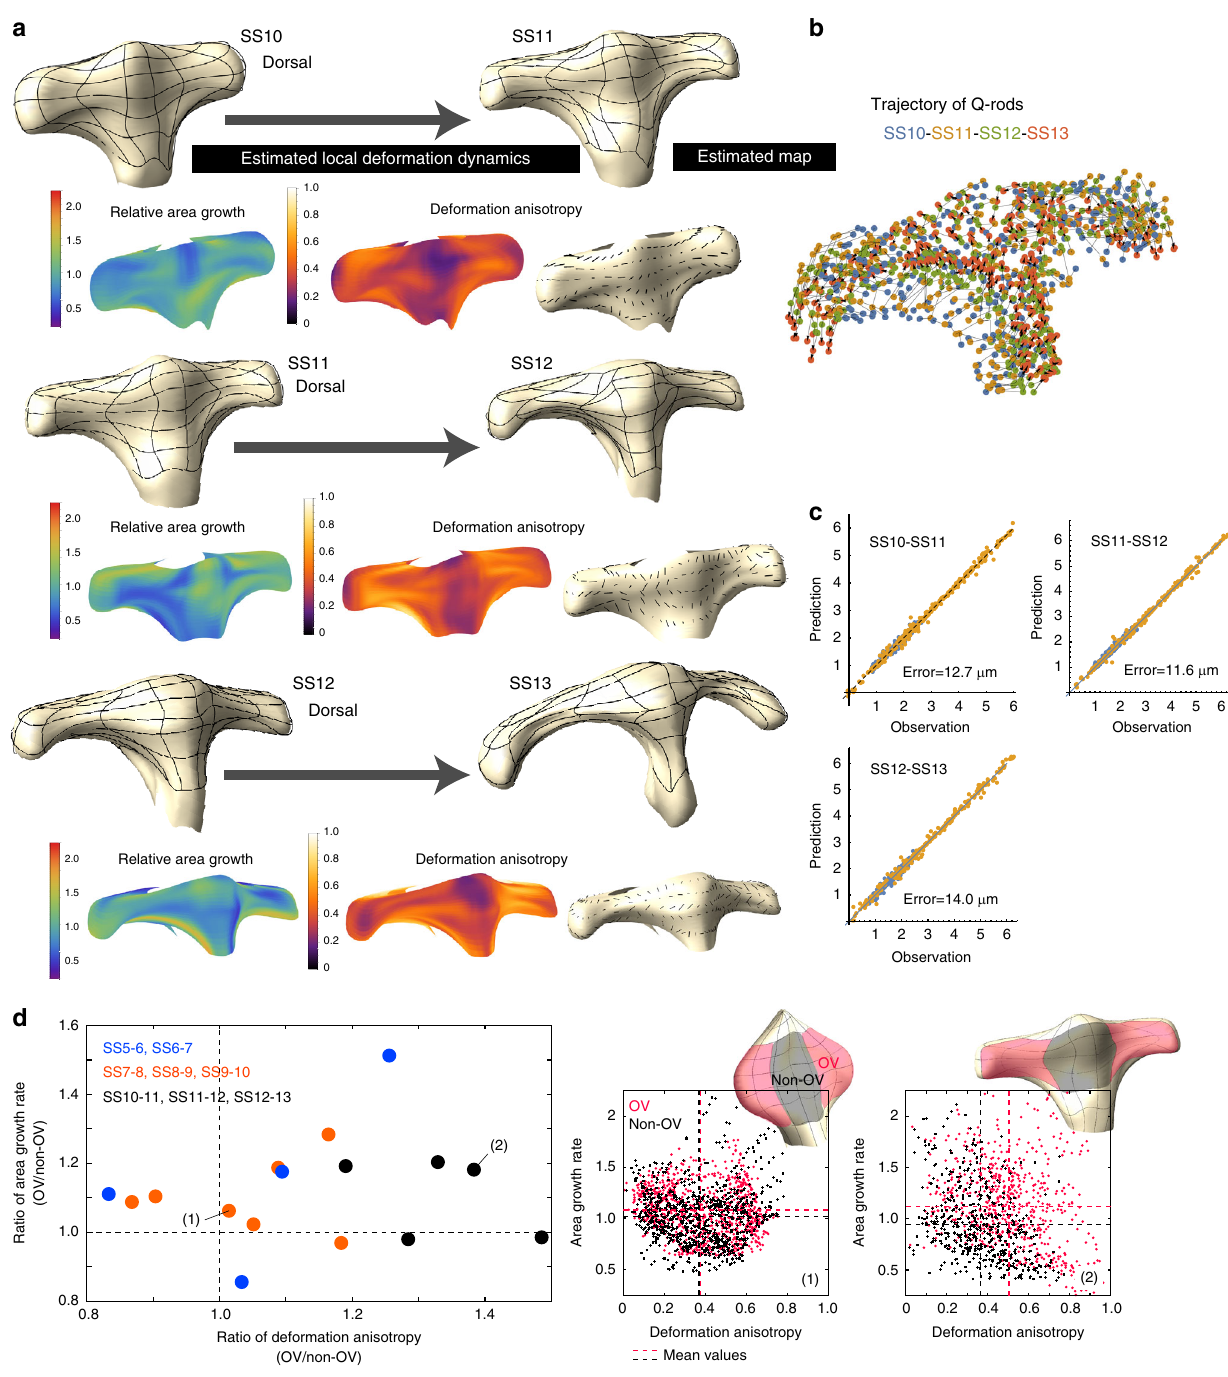
Fig. 7 Application to chick forebrain morphogenesis from SS10 to SS13. a Estimated deformation maps and spatial patterns of local deformation characteristics from SS10 to SS13 for one embryo. Due to limitations in the imaging resolution, deformation dynamics were only analyzed for the dorsal apical surface (see Supplementary Fig. 11(D) for results from another embryo). As with the case for SS5-SS10, no clear bias in area growth rate was observed. In regards to deformation anisotropy, its value remained high especially in the OV region (or evaginated region). During these somite stages, differences in the degree of anisotropy were clearer between OV and non-OV regions (quanti fi ed in ( d )). The direction of deformation anisotropy was generally biased along the medio-lateral axis although the pattern was growing more complex with the increasing morphological complexity. b Trajectory data from small aggregates of Q-rods (ranging 1 – 20 micrometers in diameter) attached to the apical surface that were used to infer the tissue deformation map. c The precision of the estimated maps was evaluated by prediction errors. The mean prediction error was on the order of a few cell diameters (on the apical surface). The yellow and blue dots indicate results for the u 1 and u 2 coordinates, respectively. d Quantitative comparison of tissue deformation characteristics on the dorsal surface between OV and non-OV regions. The left graph shows the ratio of the average degree of deformation anisotropy and the ratio of average area growth rate between these two regions. Each point shows a result for each reconstructed deformation map. The difference in deformation anisotropy between OV and non-OV regions was clearer at later stages. The right panels show examples of distributions of deformation anisotropy and area growth rate at different positions for two maps ((1) and (2) in the left panel